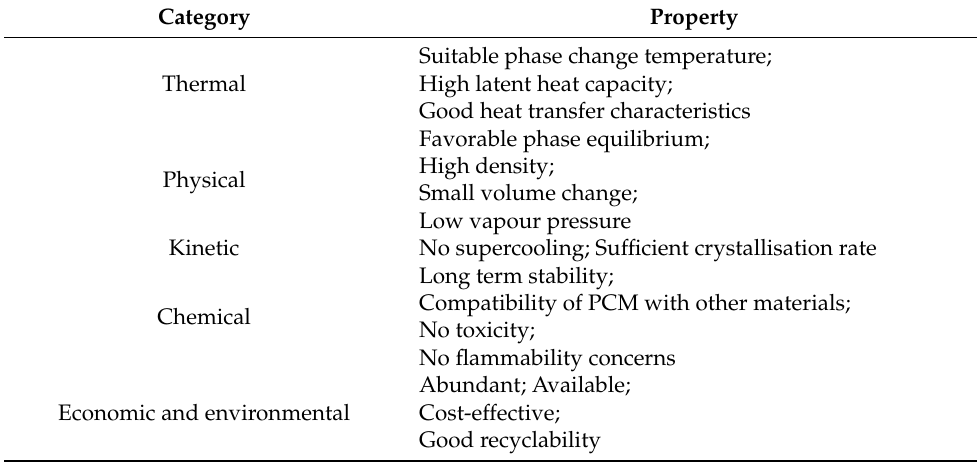
Table 14. Summary of the characteristics required for a PCM. Reprinted from ref. [17].